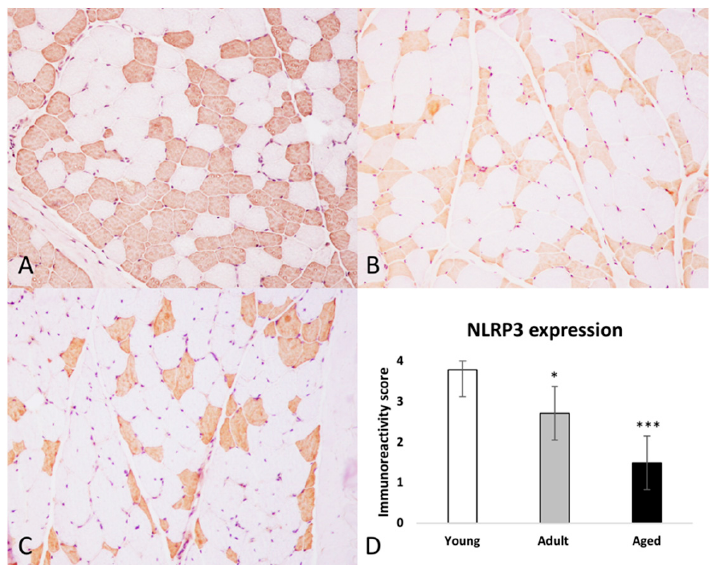
Figure 3. Immunohistochemical expression of NLRP3 in skeletal muscle in cows. ( A ) Aged cows (Group A), ( B ) Adult cows (Group B), ( C ) Young cows (Group C). HRP method with Mayer’s hematoxylin counterstain. ( D ) Immunoreactivity score for NLRP3 expression. There is a statistically significant negative association between age and the presence of NLRP3 immunolabeled muscle fibers. Each value is the mean ± SEM (* p < 0.05; *** p < 0.001).